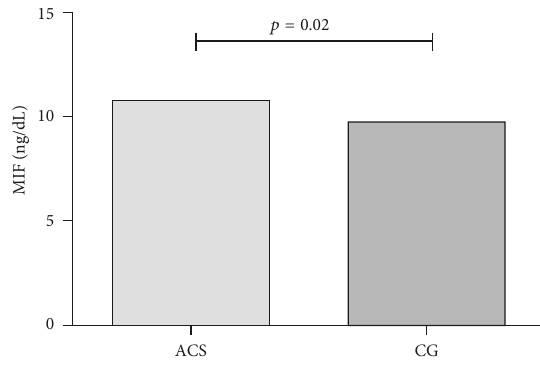
Figure 3: MIF soluble levels in ACS patients and CG. ACS patients showed significant higher MIF soluble levels ( p with CG (10.76 and 9.72ng/dL, resp).